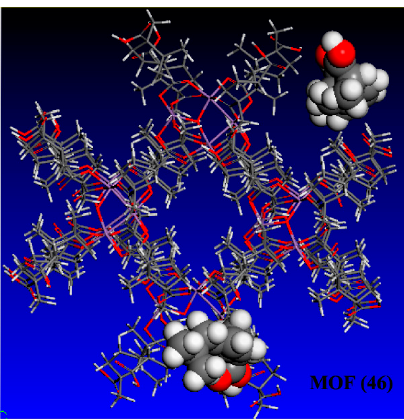
Figure 16. Possible interaction of the ( − )-ibuprofen isomer and MOF ( 46 ) viewed along the c-axis direction. Reproduced from [111] with permission from the American Chemical Society.